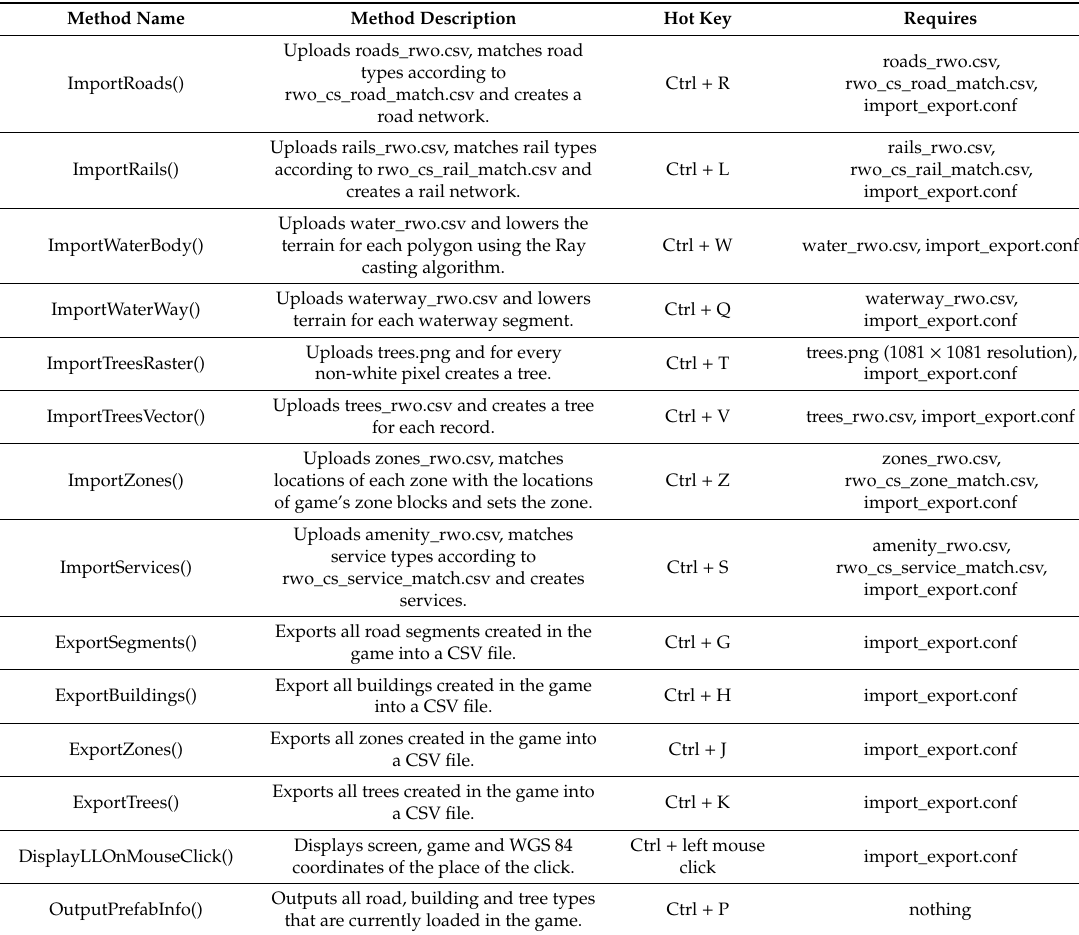
Table 2. List of methods of the GeoSkylines game